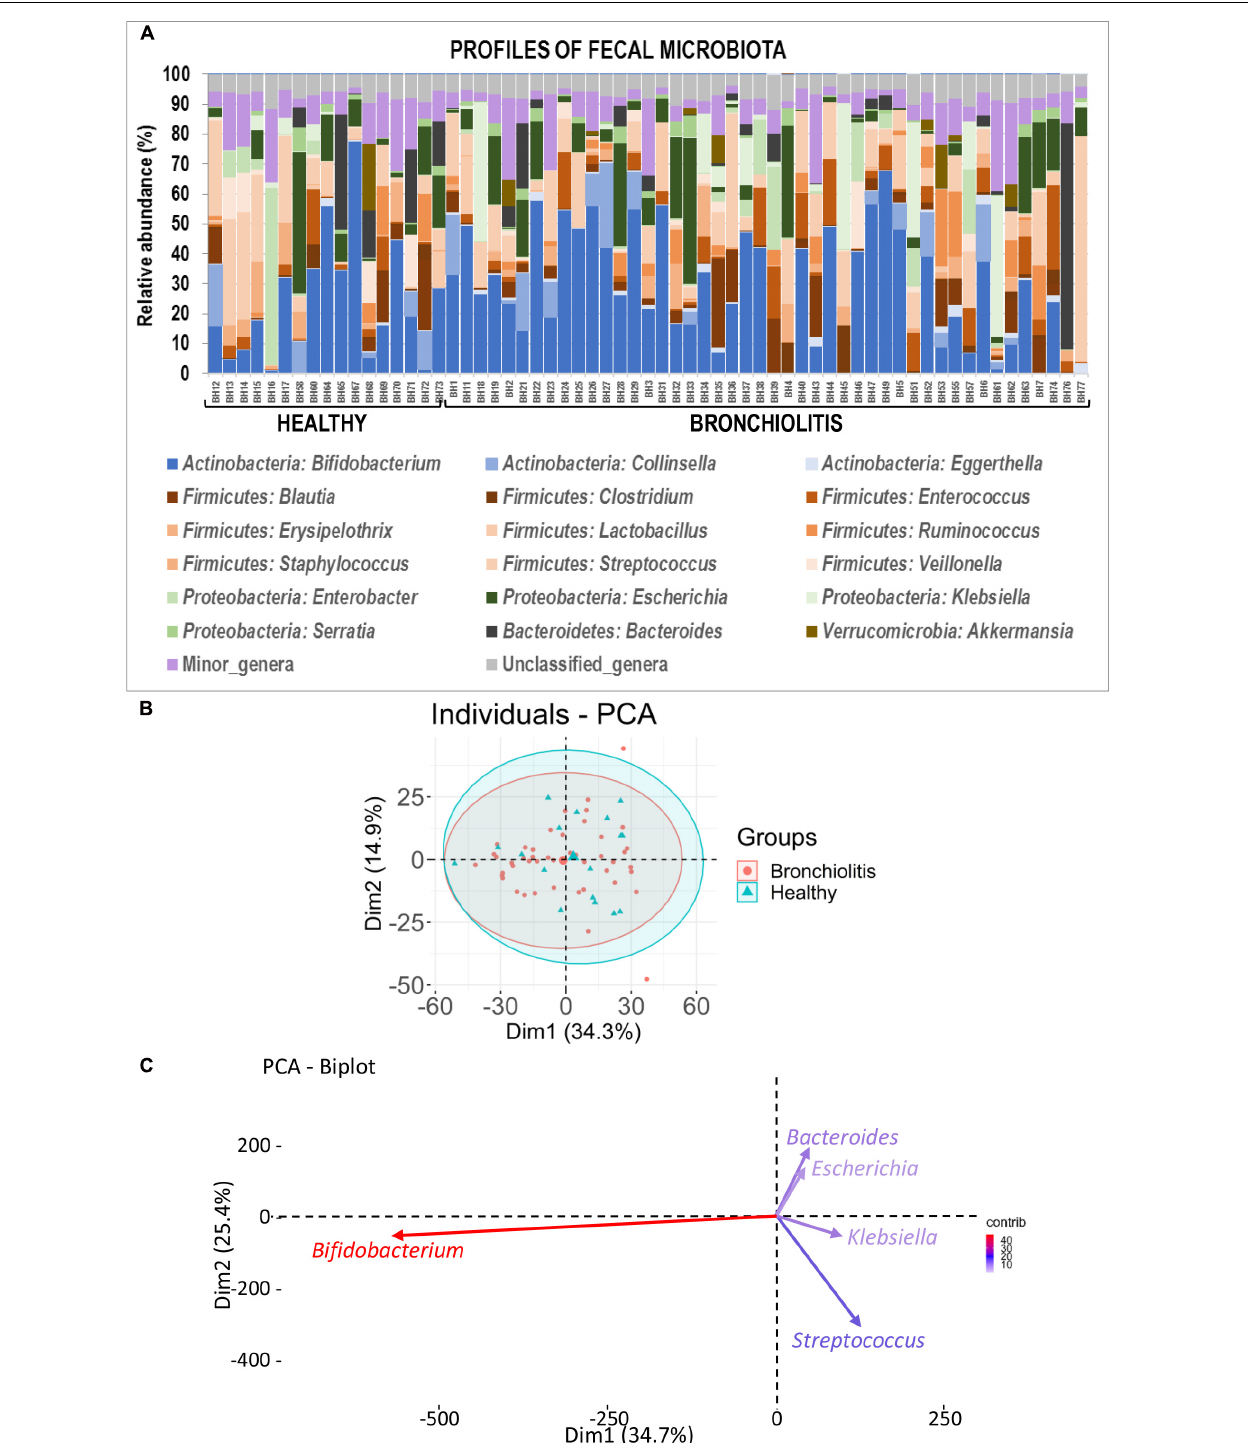
FIGURE 6 | Fecal microbiota in healthy controls and bronchiolitis groups. (A) Individual profiles of the microbiota composition at the genus level (the 20 most abundant genera) of nasal samples from healthy control and bronchiolitis groups. Each stacked bar represents one sample and depicts the average relative abundance of the most abundant bacterial genera (color-coded). (B) Principal component analysis (PCA) for nasal samples based on the bacterial composition at the genus level showing the sample distribution around centroids (ellipses were defined by a 95% confidence interval). (C) Most influential genera ( cos 2 > 0.2) on sample separation presented in panel (B)